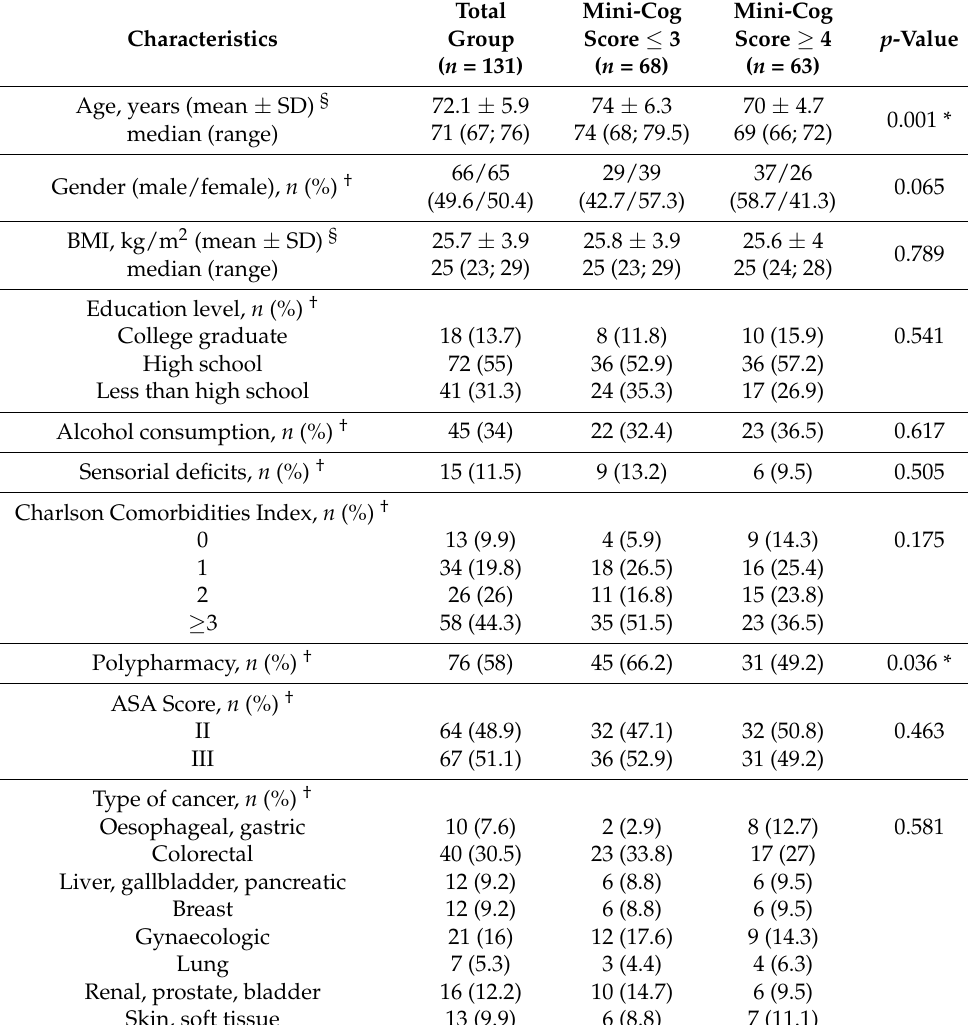
Table 1. Preoperative variables in elderly cancer patients according to Mini-Cog score.